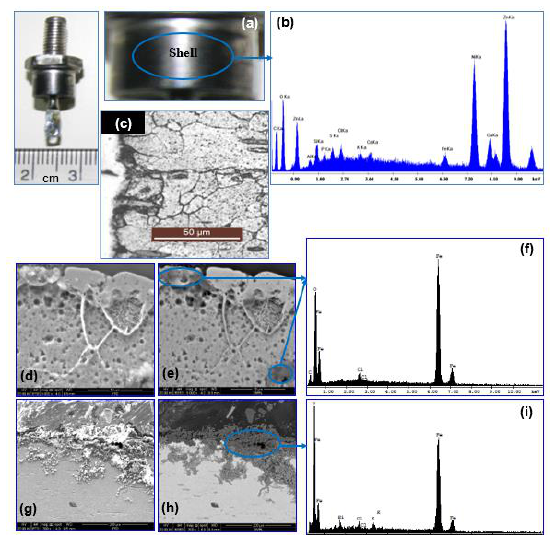
Figure 6: (a) Magnified photograph of the diode shell of Figure 3a,b in the as-received condition showing the corrosion, (b) EDS results of the corrosion debris sitting on the shell, (c) optical micrograph of the corroded shell, (d,e) corrosion along the coating and deep inside the structure, (f) EDS analysis for the corrosion product shown in Figs. (d,e), (g,h) severe corrosion of the shell material along an edge in absence of coating, (i) EDS analysis for the corrosion product shown in Figs.